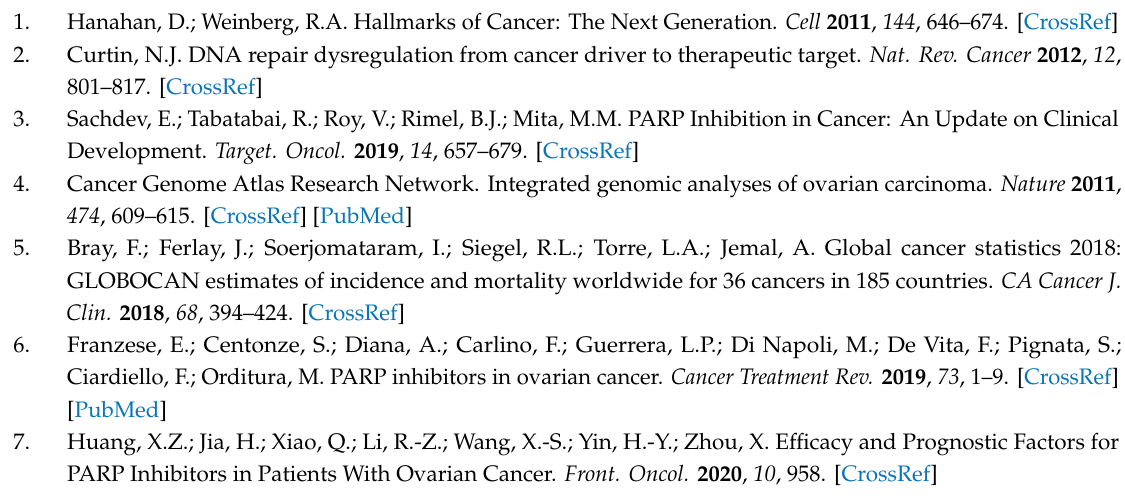
Figure S1: Sensitivity of NIH-OVCAR3 cells to Cisplatin, Figure S2: Confirmation of loss of TP53 function in NIH-OVCAR3 cells, Figure S3: Western blot confirming the loss of TP53 function in NIH-OVCAR3 cells, Figure S4: Western blot of ATR activation and inhibition by 4NQO ± VE-821 in NIH-OVCAR3 cells, Figure S5: Western blot of baseline protein expression in panel of ovarian cancer cell lines, Table S1: Cisplatin sensitivity, Table S2: Additional drug sensitivity, Table S3: Culture medium of additional 12 ovarian cancer cell lines used for comparison to the NIH-OVCAR3 cell line, Table S4: mRNA expression in platinum-sensitive and resistant